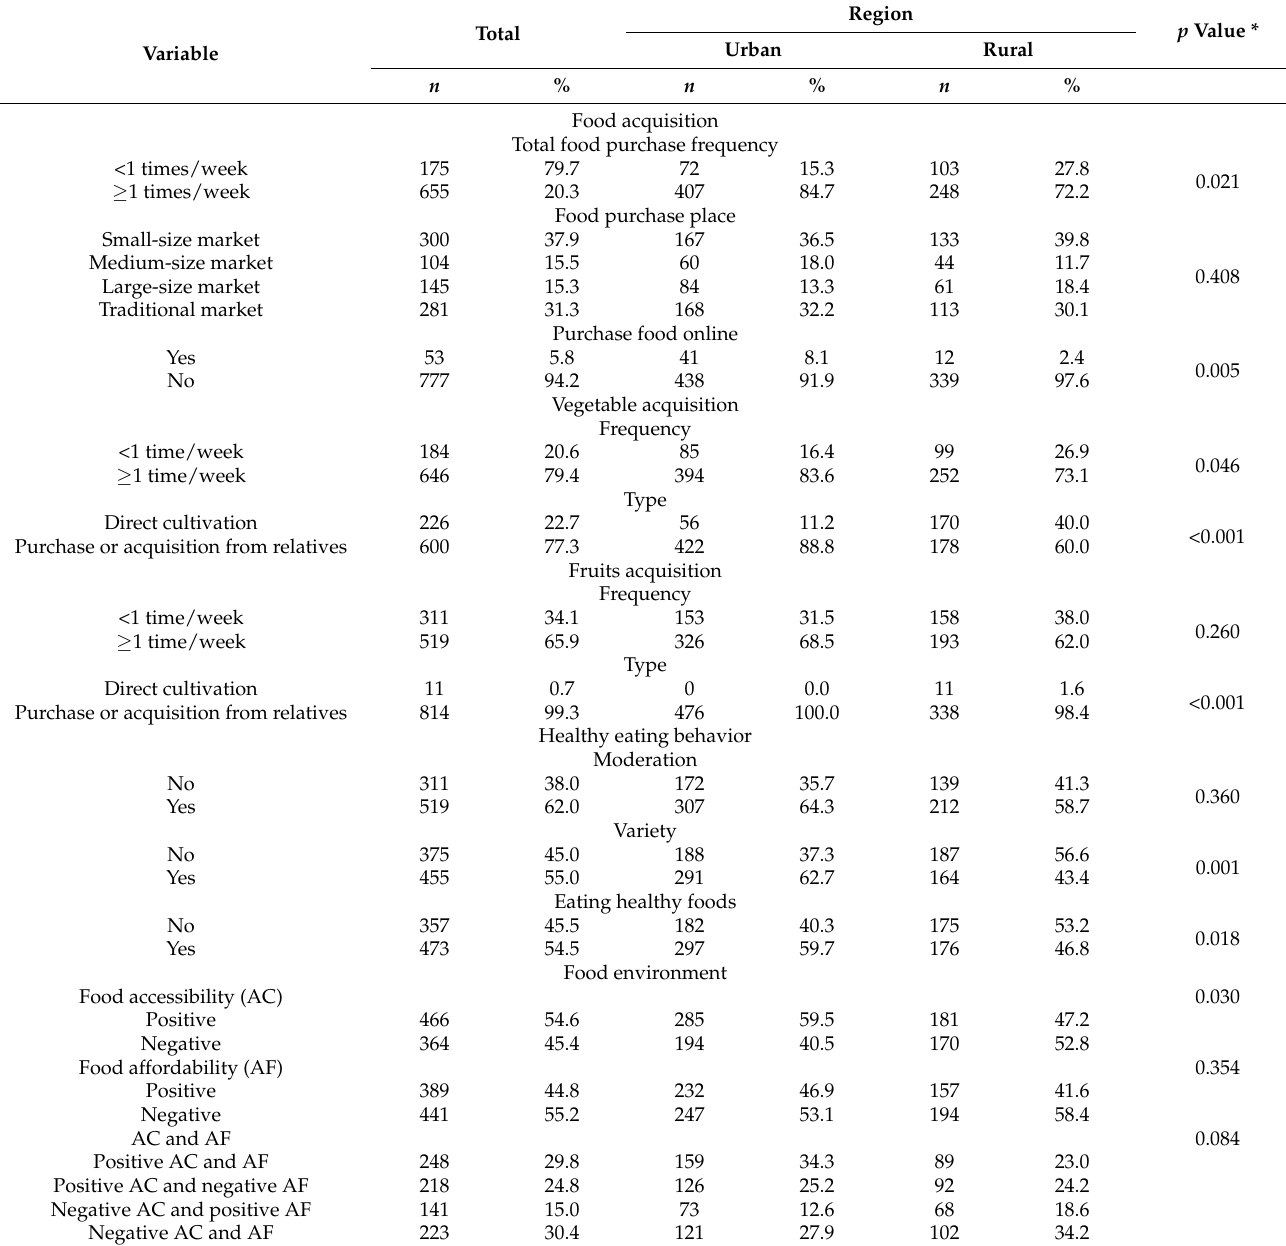
Table 2. Characteristics of food acquisition, healthy eating behaviors, and perceived food environment by